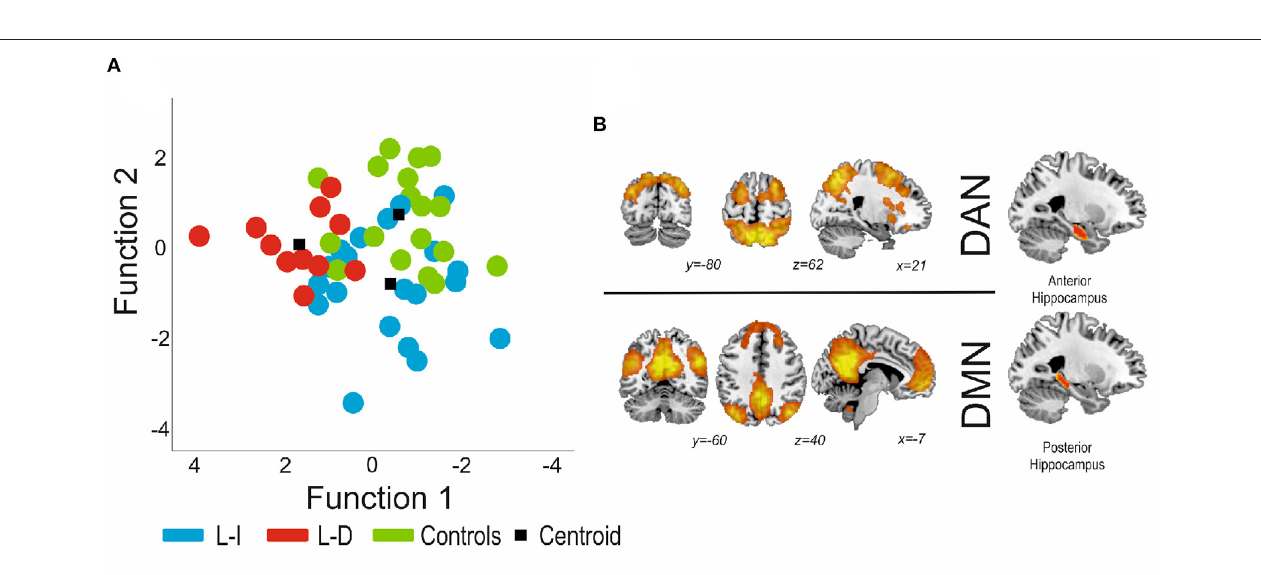
FIGURE 4 | (A) Canonical functions distribution of the discriminant analysis. Function 1 was found to significantly distinguish patients with decline from patients without decline and controls. (B) The connectivity variables with higher load were both for the pathological hippocampus (posterior part indicates connectivity with the DMN, and the anterior portion indicates connectivity with the DAN). DMN, Default Mode Network; DAN, Dorsal Attention